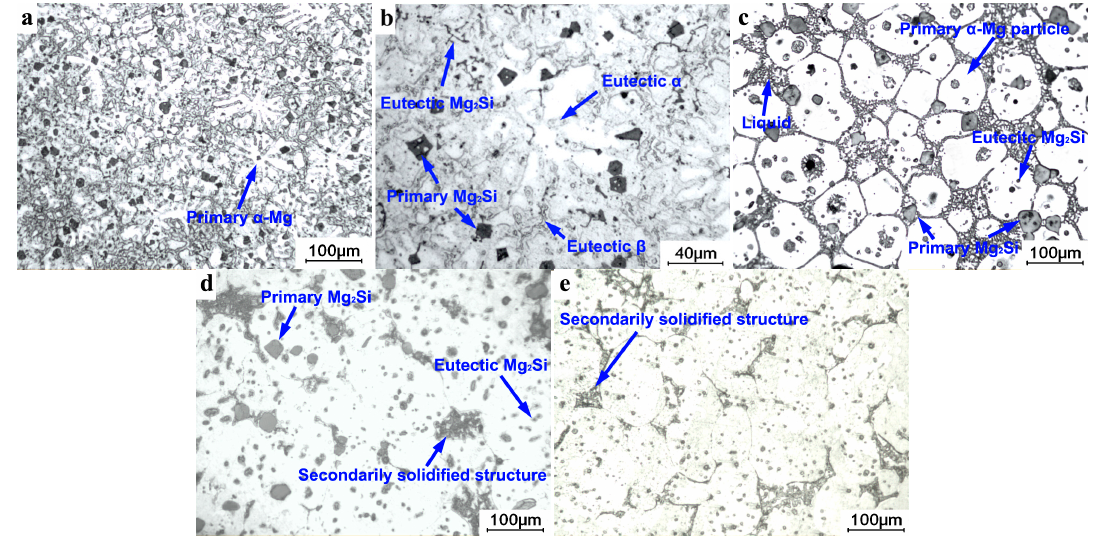
Figure 1. Microstructures of: ( a , b ) as-cast composite; ( c ) semisolid composite; ( d ) thixoforged composite; ( e ) thixoforged AM60B.